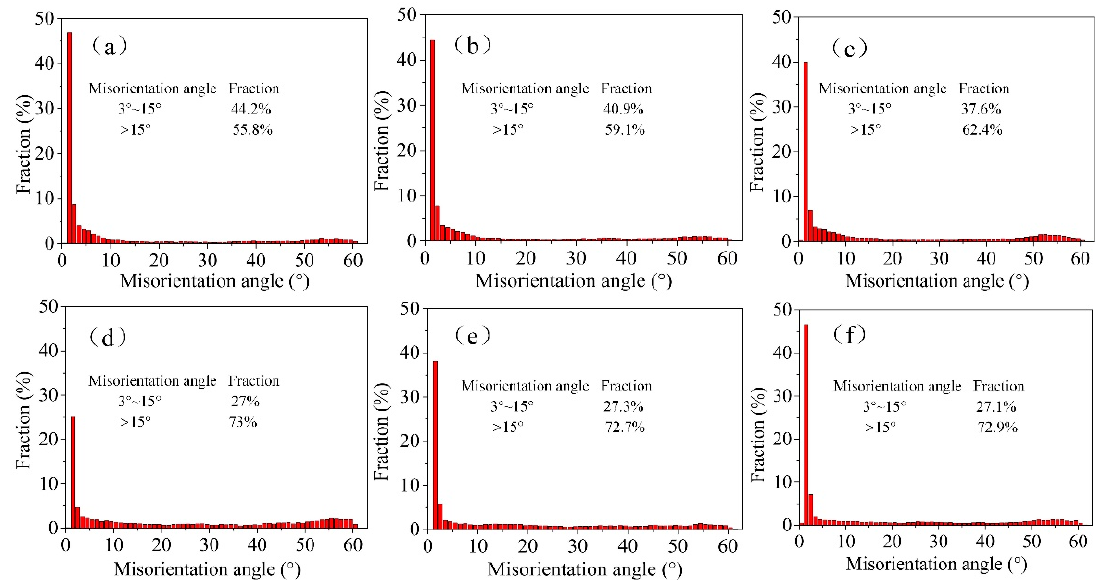
Figure 8. Electron backscatter diffraction (EBSD) images for the rolling specimens with thicknesses of